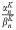
Plots of total concentrations of kinase and phosphatase as functions of free kinase and phosphatase.The intersections correspond to steady states (S1 Text, S1.1). The stable steady states are coloured in black, whereas the unstable steady states are coloured in red. Increasing the strength of both the Substrate Kinase (αnKβnK) and Substrate Phosphatase-Sequestration (α0Pβ0P), the number of steady states (and stable steady states) falls in a continuous fashion from 5 (3 stable), as in the system without any sequestration, to 3 (2 stable) and then to 1 (1 stable).